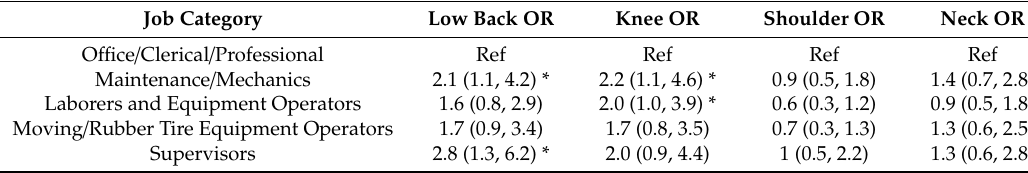
Table 4. Odds ratios of MSS by job category.